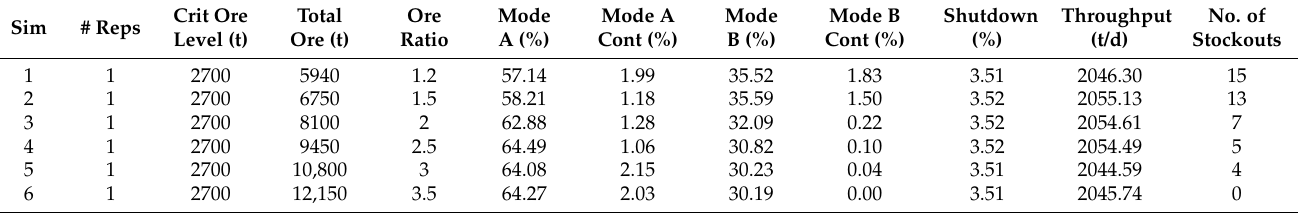
Table 3. Summary of modal time proportions, throughput rates and number of stockout events for simulations with varied ore type ratios using a constant critical RTO level of 2700 t (deterministic result).